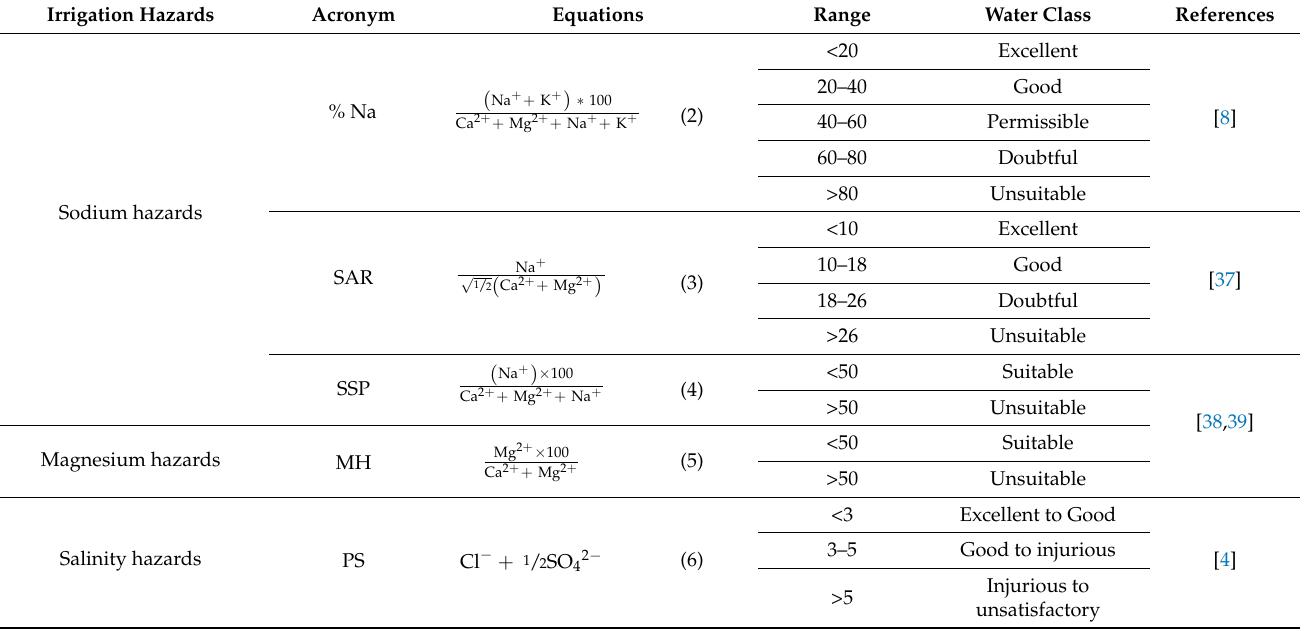
Table 2. Indices for measuring the irrigation